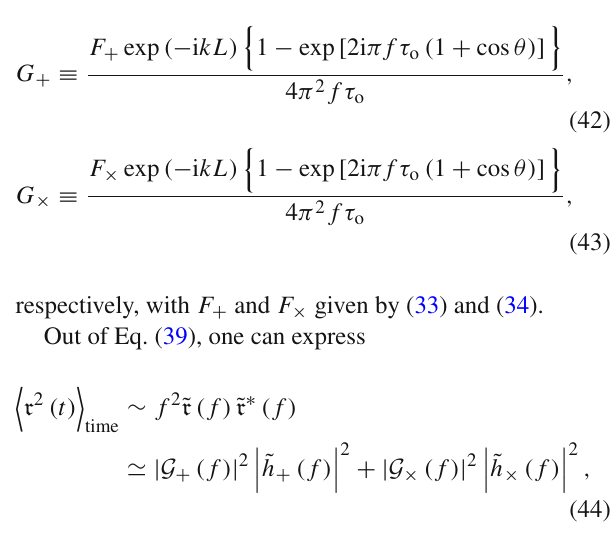
with F + , F × and cos γ 1 given by (27), (31) and (28),